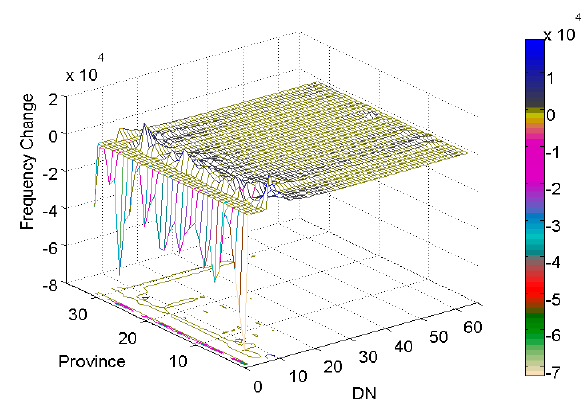
Figure 8. Frequency change of the entire DN series between 2000 and 2012.